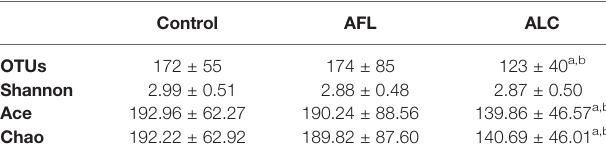
Data represent as mean ± standard deviation (SD) Statistical analyses were performed with Wilcoxon rank-sum test. a, compared to control group, *P < 0.05. b, compared to AFL group, *P <